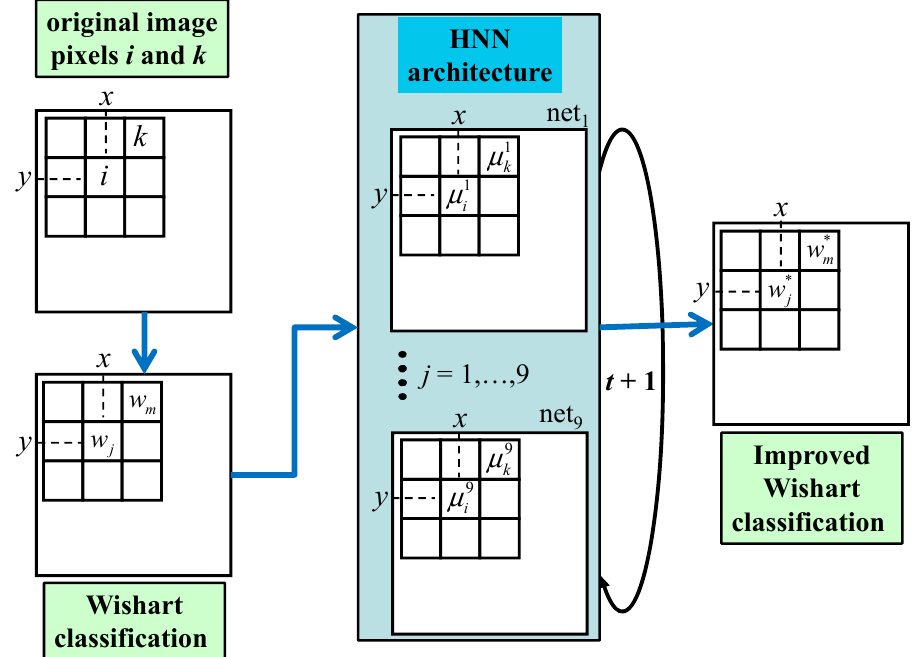
Figure 1. Flowchart of the overall procedure and architecture for the Hopfield Neural Network (HNN)